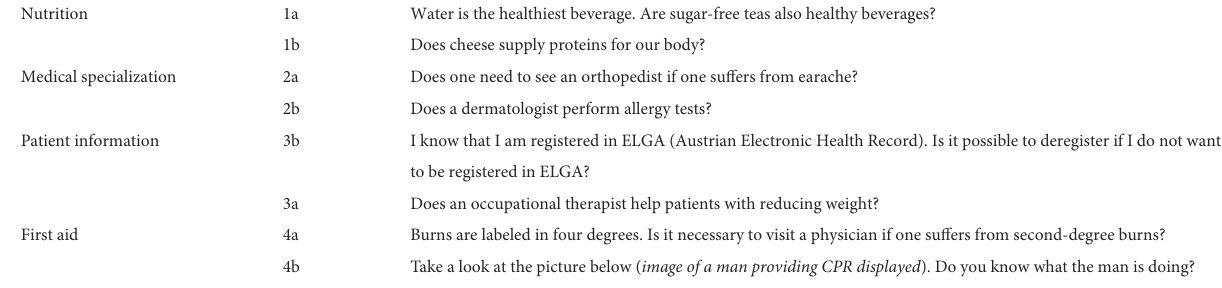
TABLE 1 Eight questions that participants with ID were asked across four domains of health-related knowledge transfer.